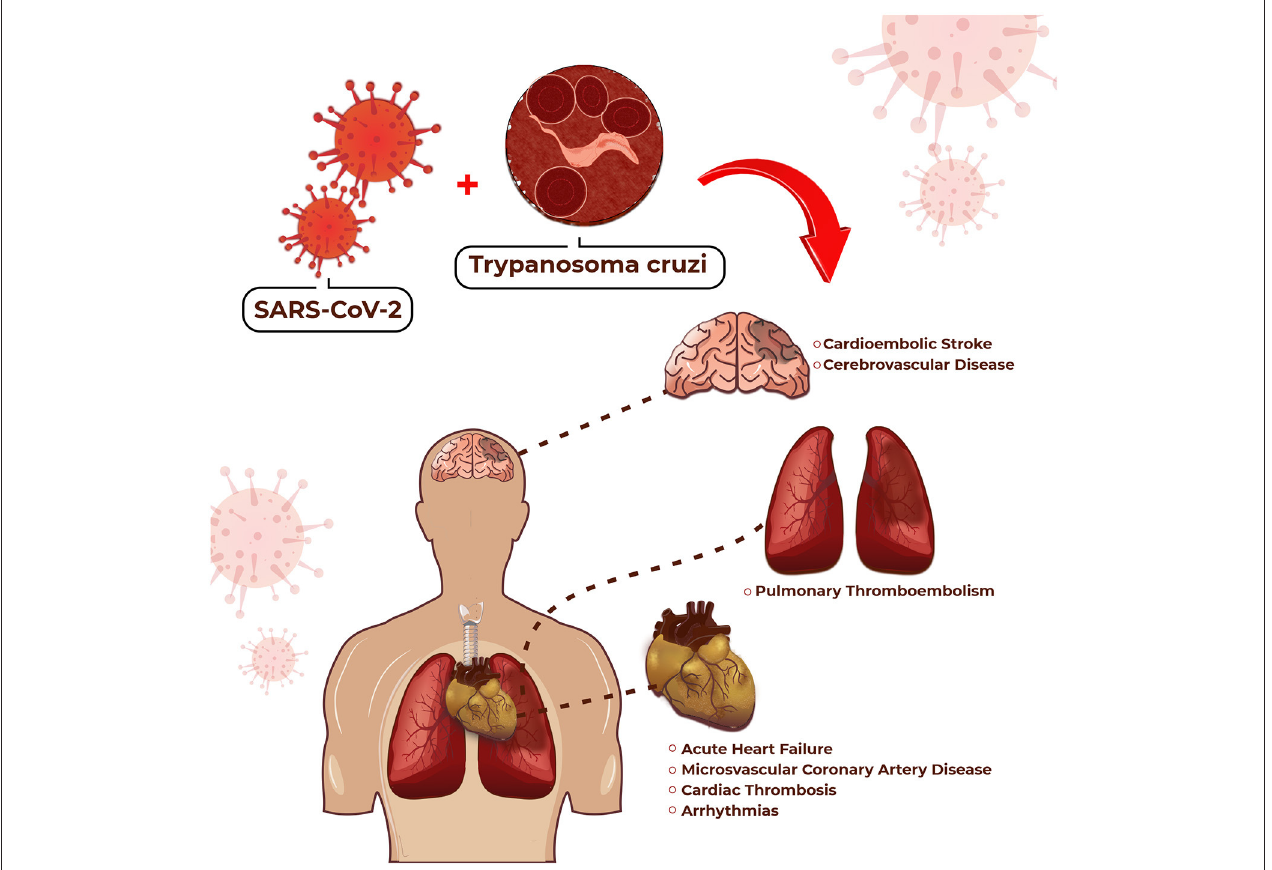
FIGURE 1 | Potential cardiovascular complications in patients with CCHD and